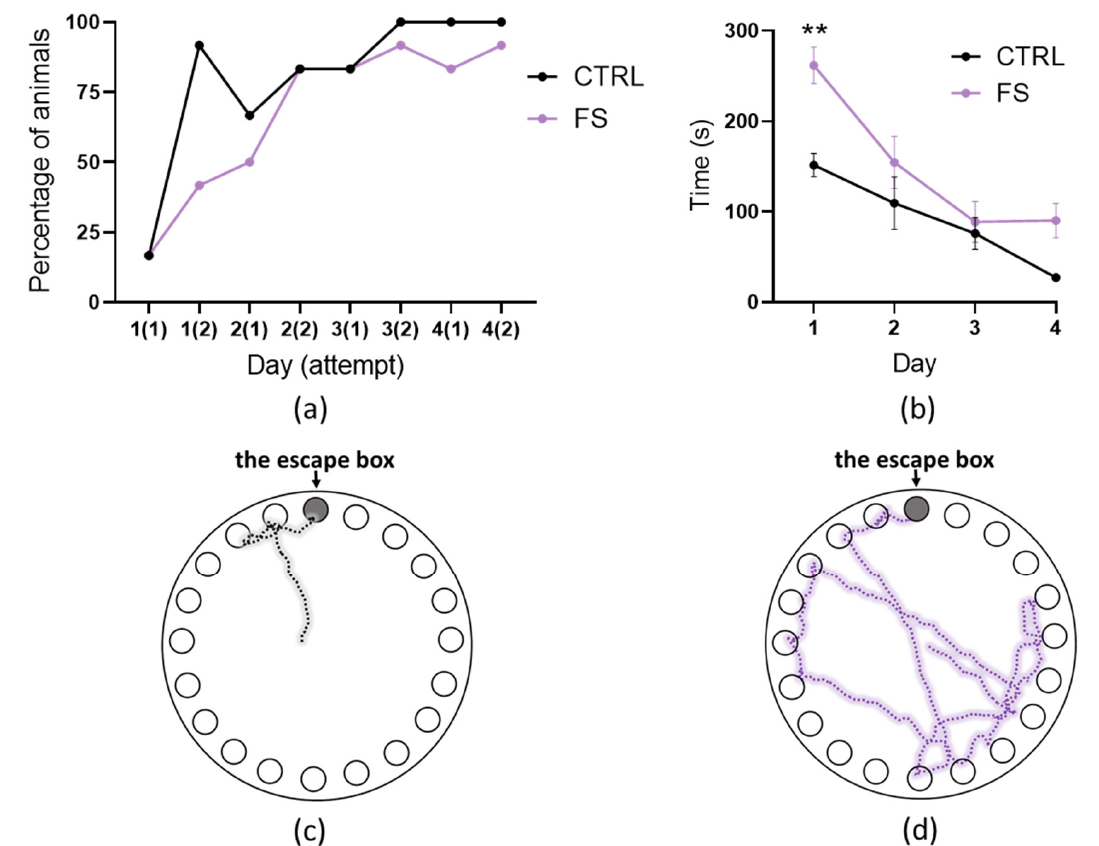
Figure 5. Training session (days 1 to 4) in the Barnes maze. ( a ) The percentage of control rats (CTRL) and rats after FSs (FS) that successfully completed each attempt. ( b ) Time spent searching for the escape box by control (CTRL) and experimental (FS) animals. Results of two-way ANOVA reported in the text. Asterisks indicate significant differences between groups according to Tukey’s post hoc tests: ** p < 0.01. Representative examples of the pathways of a control rat ( c ) and an FS rat ( d ) in the Barnes maze on day 4 (second attempt).